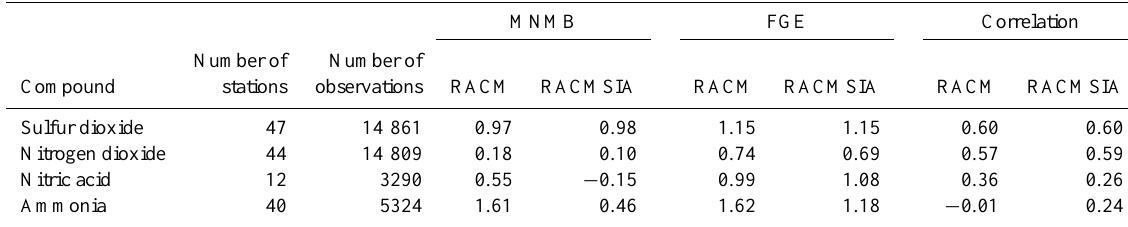
Table 13. Gaseous compound statistics of simulation results against daily EMEP observations. Comparison between a simulation with SIA (RACMSIA) and without SIA formation (RACM).